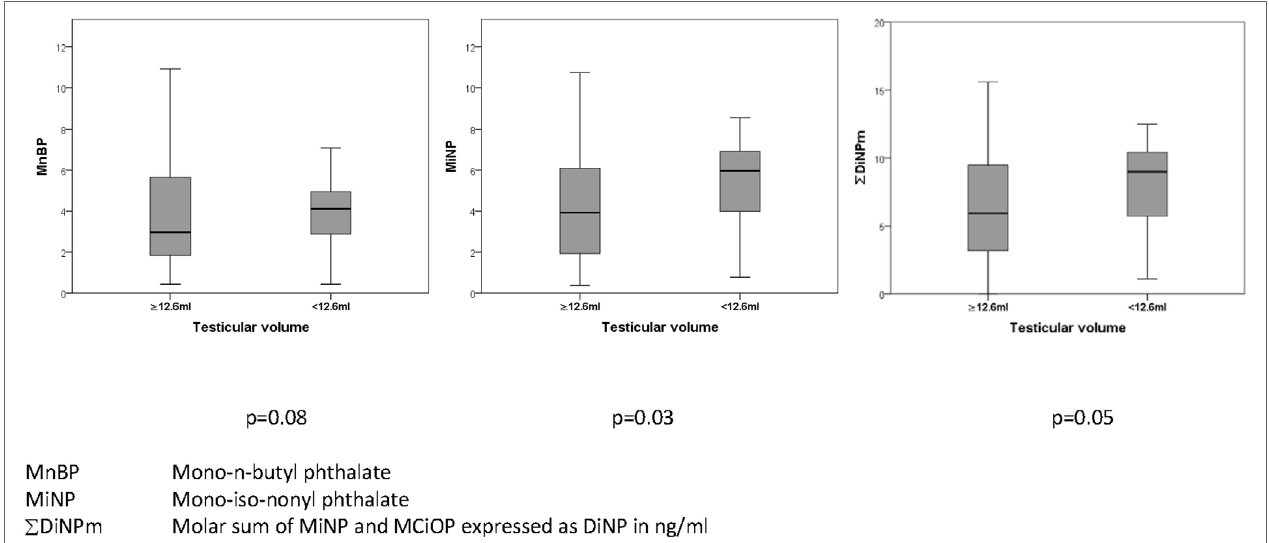
FigUre 1 | Association of prenatal maternal serum phthalates (nanograms/milliliter) with testicular volume (milliliter) in their adult